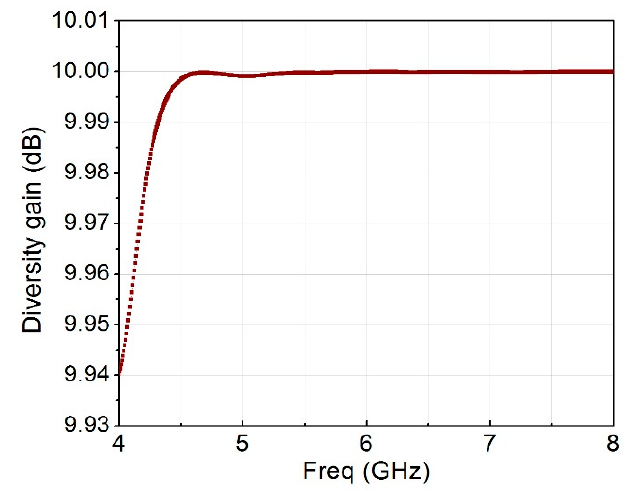
Figure 20. Diversity gain of the MIMO antenna.